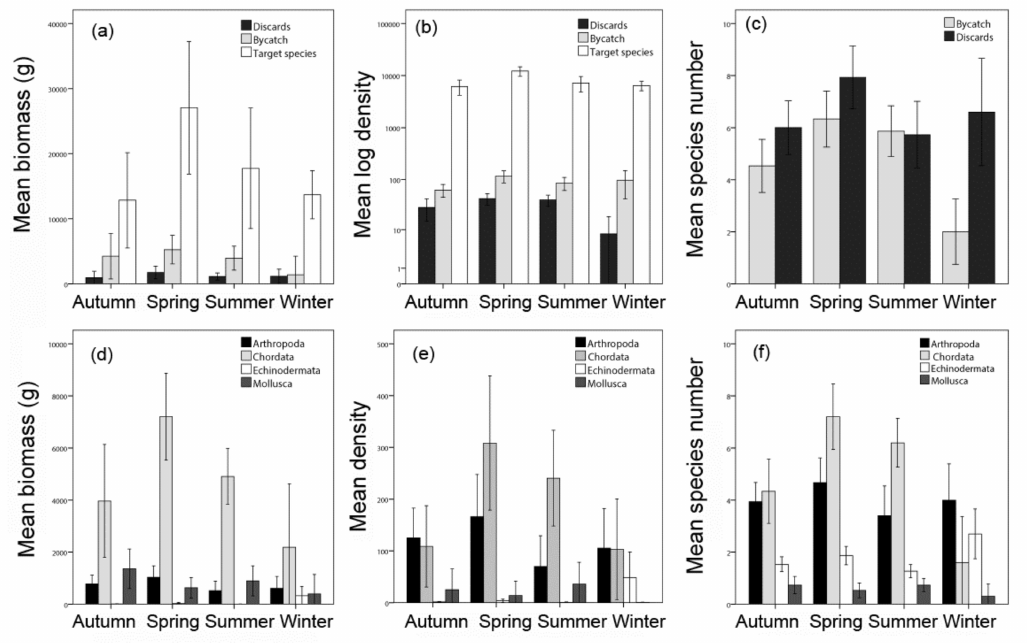
Figure 3. Seasonal variation expressed as the mean ± standard deviation in ( a ) biomass, ( b ) density, and the ( c ) number of targeted species, bycatch and discards. Seasonal variations represented as the mean ± standard deviation in ( d ) biomass, ( e ), density and ( f ) number of species for the four major Phyla (i.e., Arthropoda, Chordata, Echinodermata and